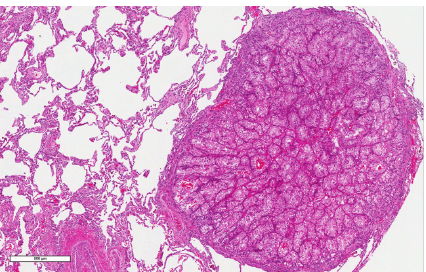
Figure 2: Metastatic renal cell carcinoma. Photomicrograph shows a metastatic focus (hematoxylin-eosin, original magnification ×